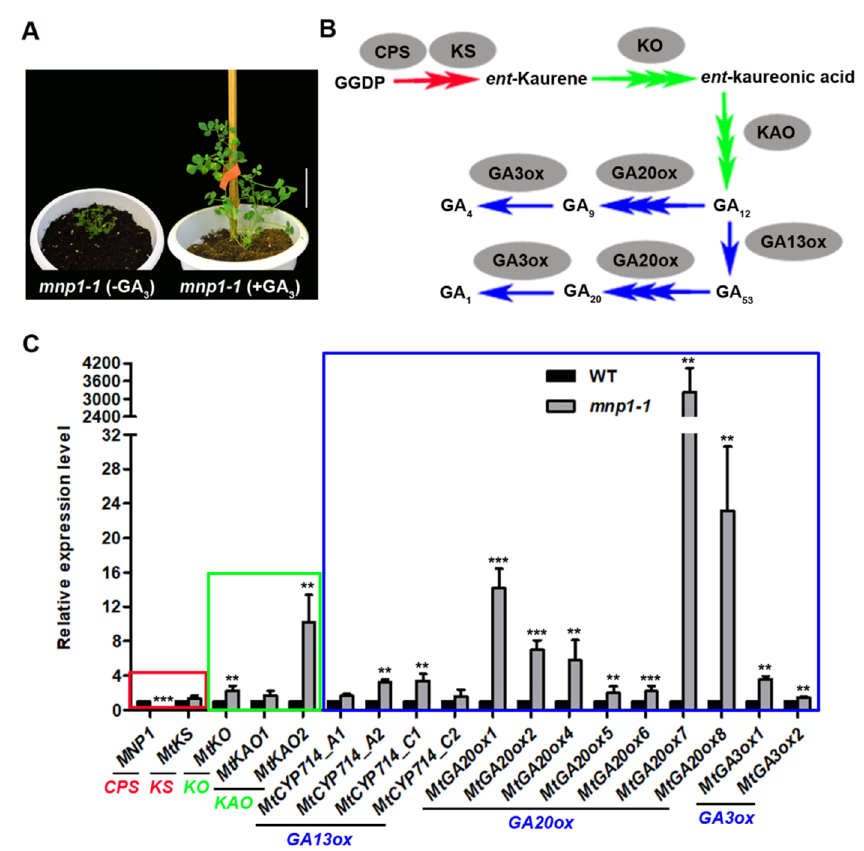
Figure 5. Expression analysis of GA biosynthesis genes in GA-sensitive mutant mnp1-1 . ( A ) From left to right are mnp1-1 without GA 3 treatment and mnp1-1 with 70 uM GA 3 treatment. Scale bar = 4 cm. ( B ) GA biosynthesis pathway schematic diagram. The red, green and blue arrows represent the three stages of GA biosynthesis pathway. Gray ovals represent enzymes. ( C ) Relative expression levels of GA biosynthesis genes in the stem of WT and mnp1-1 . The red, green and blue boxes represent the three stages of GA biosynthesis pathway as in ( B ). The significant difference was determined by unpaired two-sample t -test ( ** p < 0.01, *** p < 0.001).